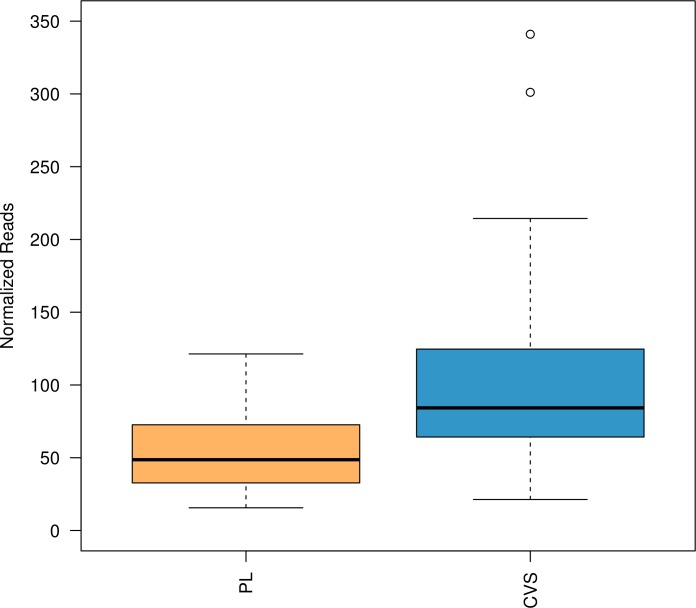
DMR methylation enrichment of the previously confirmed 331 fetal-specific DMRs in 29 CVS and 27 non-pregnant female plasma samples.Boxplots show the distribution of the enrichment (normalized reads) between the two tissues; plasma (orange) and CVS (blue). The boxplots were calculated from values across all samples and all DMRs. Methylation analysis showed significant difference in the enrichment between the two tissues (p<2e-16) with higher enrichment in CVS compared to female non-pregnant plasma samples. CVS: Chorionic Villus Samples, PL: female non-pregnant plasma sample.